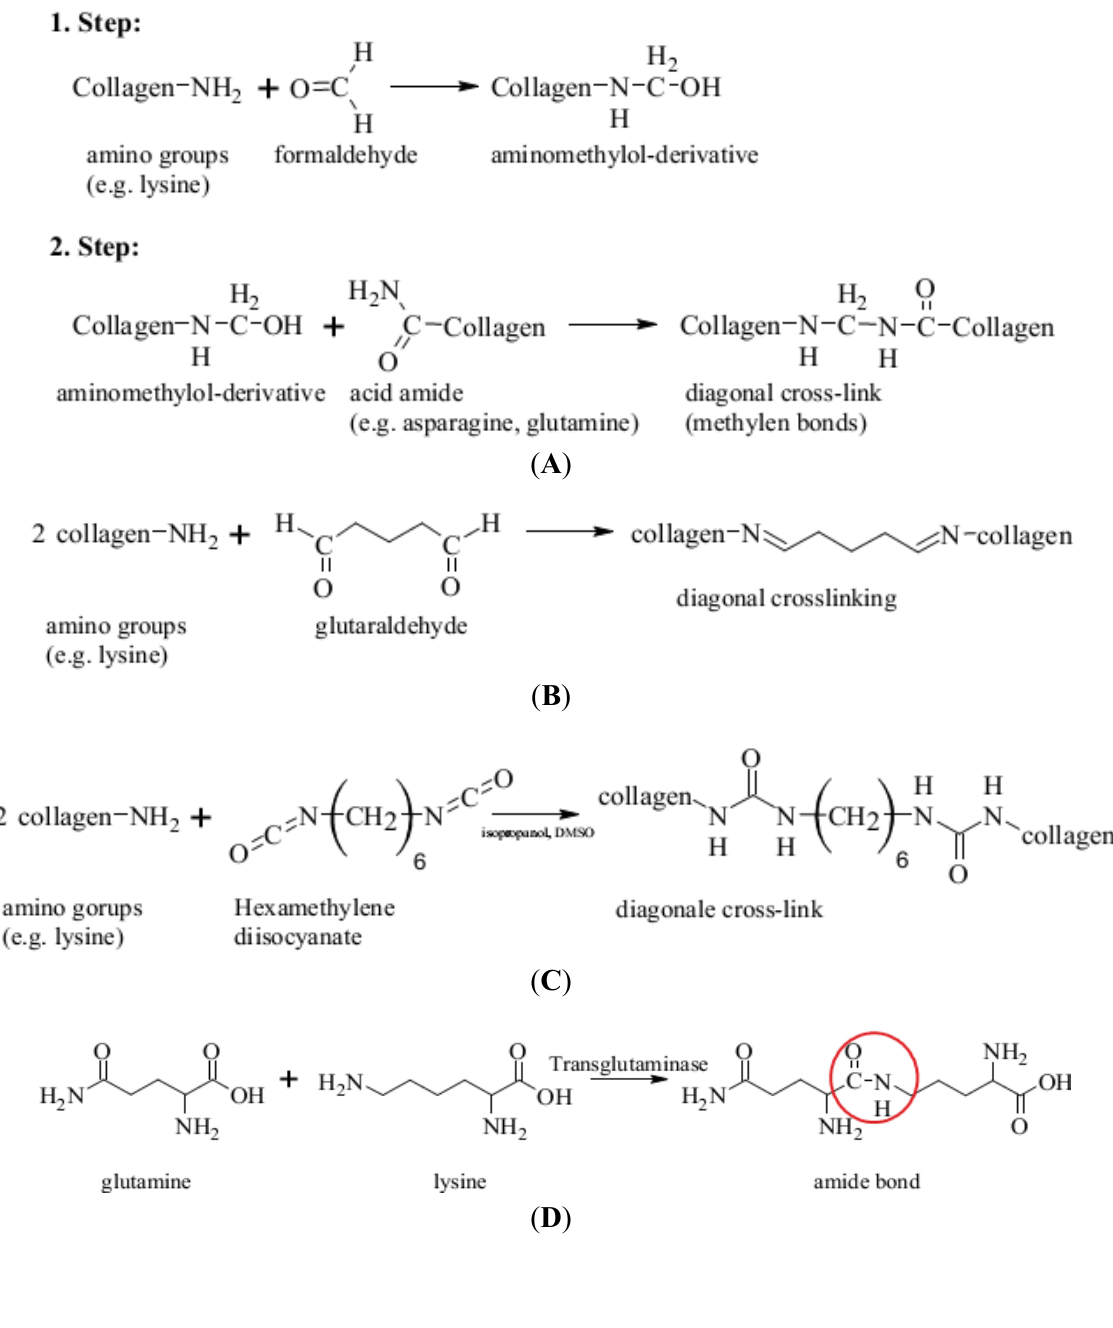
Figure 4. Cross-linking reactions. ( A ) Cross-linking via formaldehyde. In the first step amino groups of collagen (e.g., in lysine entities) react with formaldehyde to form an aminomethylol-derivative. In the second step, a diagonal cross-link is formed by reaction of the aminomethylol-derivative with an acid amide; ( B ) Cross-linking via glutaraldehyde. Reaction of amino groups of two collagen molecules (e.g., in lysine entities) with glutaraldehyde leads to diagonal crosslinking of collagen molecules; ( C ) Cross-linking via hexamethylene diisocyanate. Hexamethylene diisocyanate can react with amino groups to crosslink collagens; ( D ) Cross-linking via enzymes. During enzymatic cross-linking with transglutaminase an amide bond is generated via conversion of glutamine and lysine